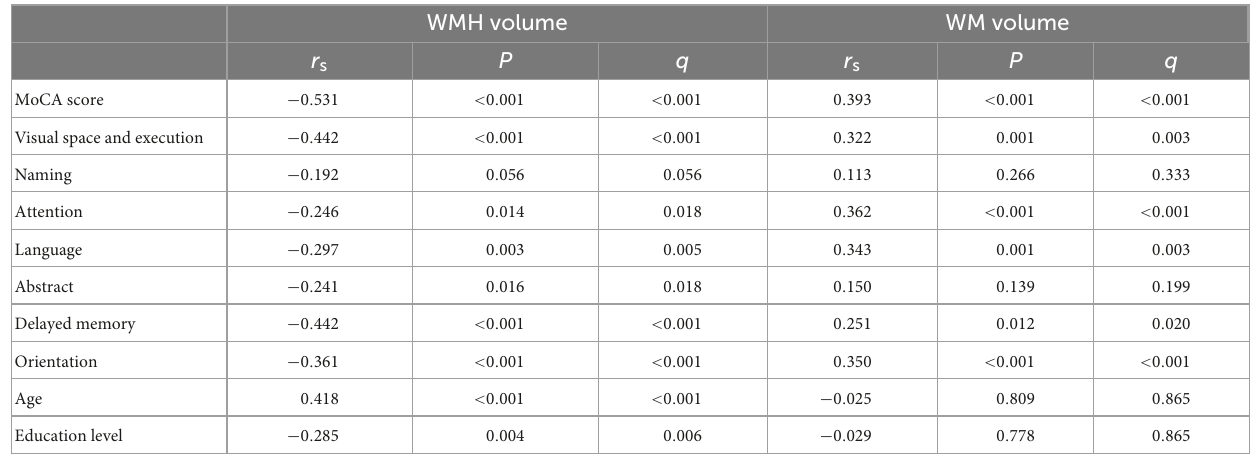
TABLE 4 Results of the correlation